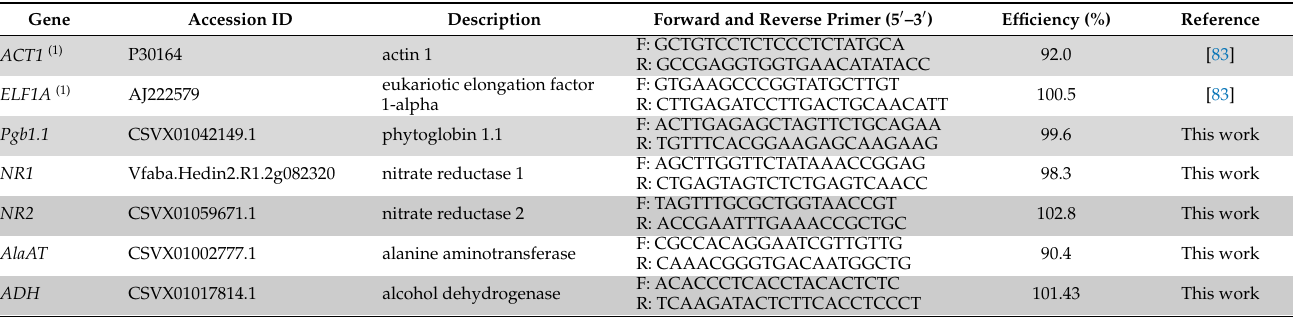
Table 1. Primers used for qRT-PCR